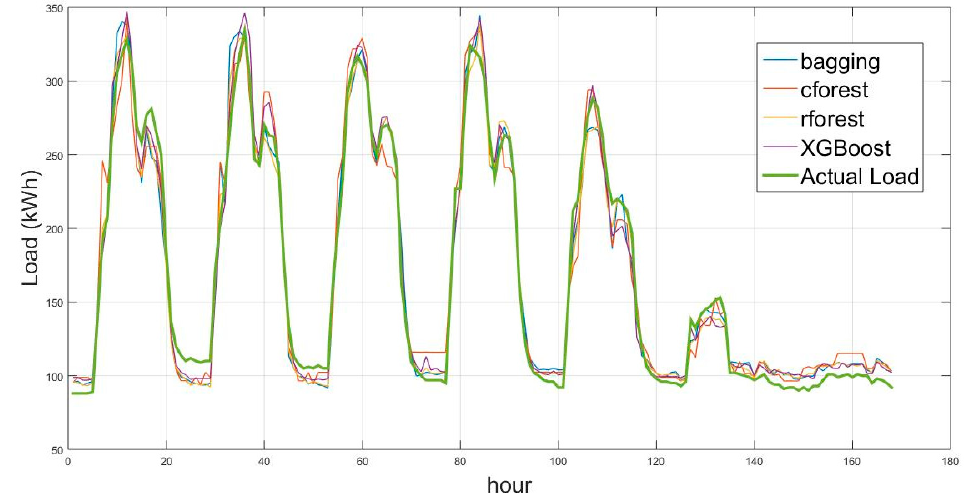
Figure 3. Actual and forecasting load (kWh) for a week (9–15 May 2016).